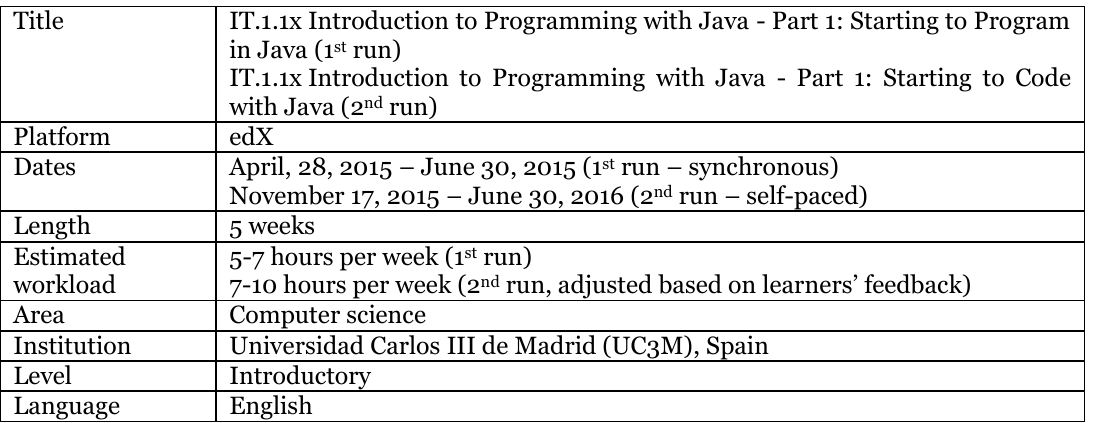
General Information on MOOC Titled Introduction to Programming with